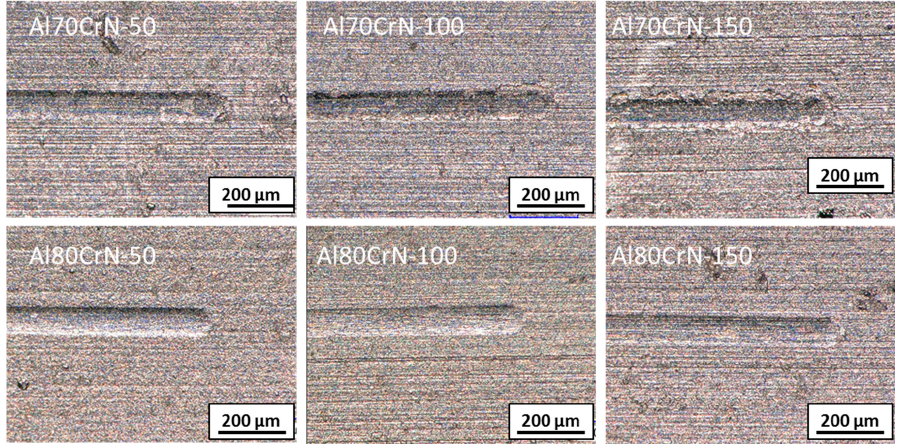
<= 70N) for all coating